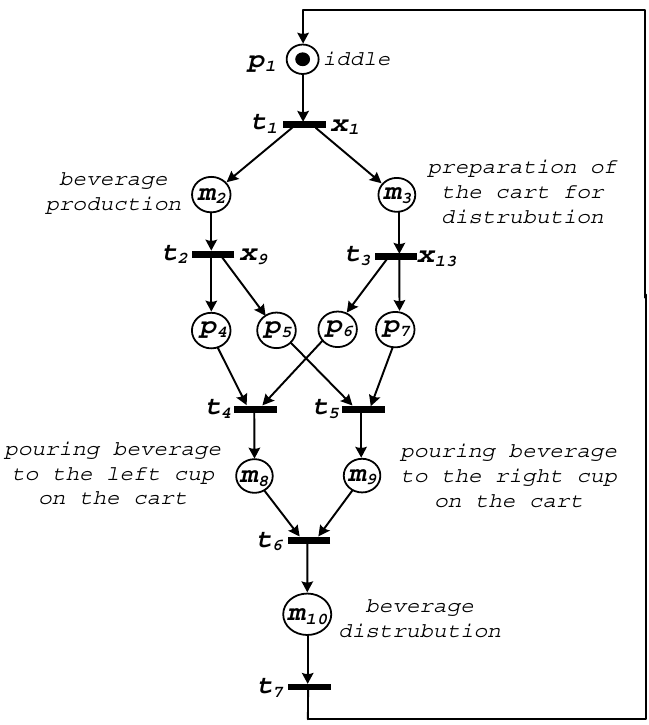
Figure 5. A top module of the system.